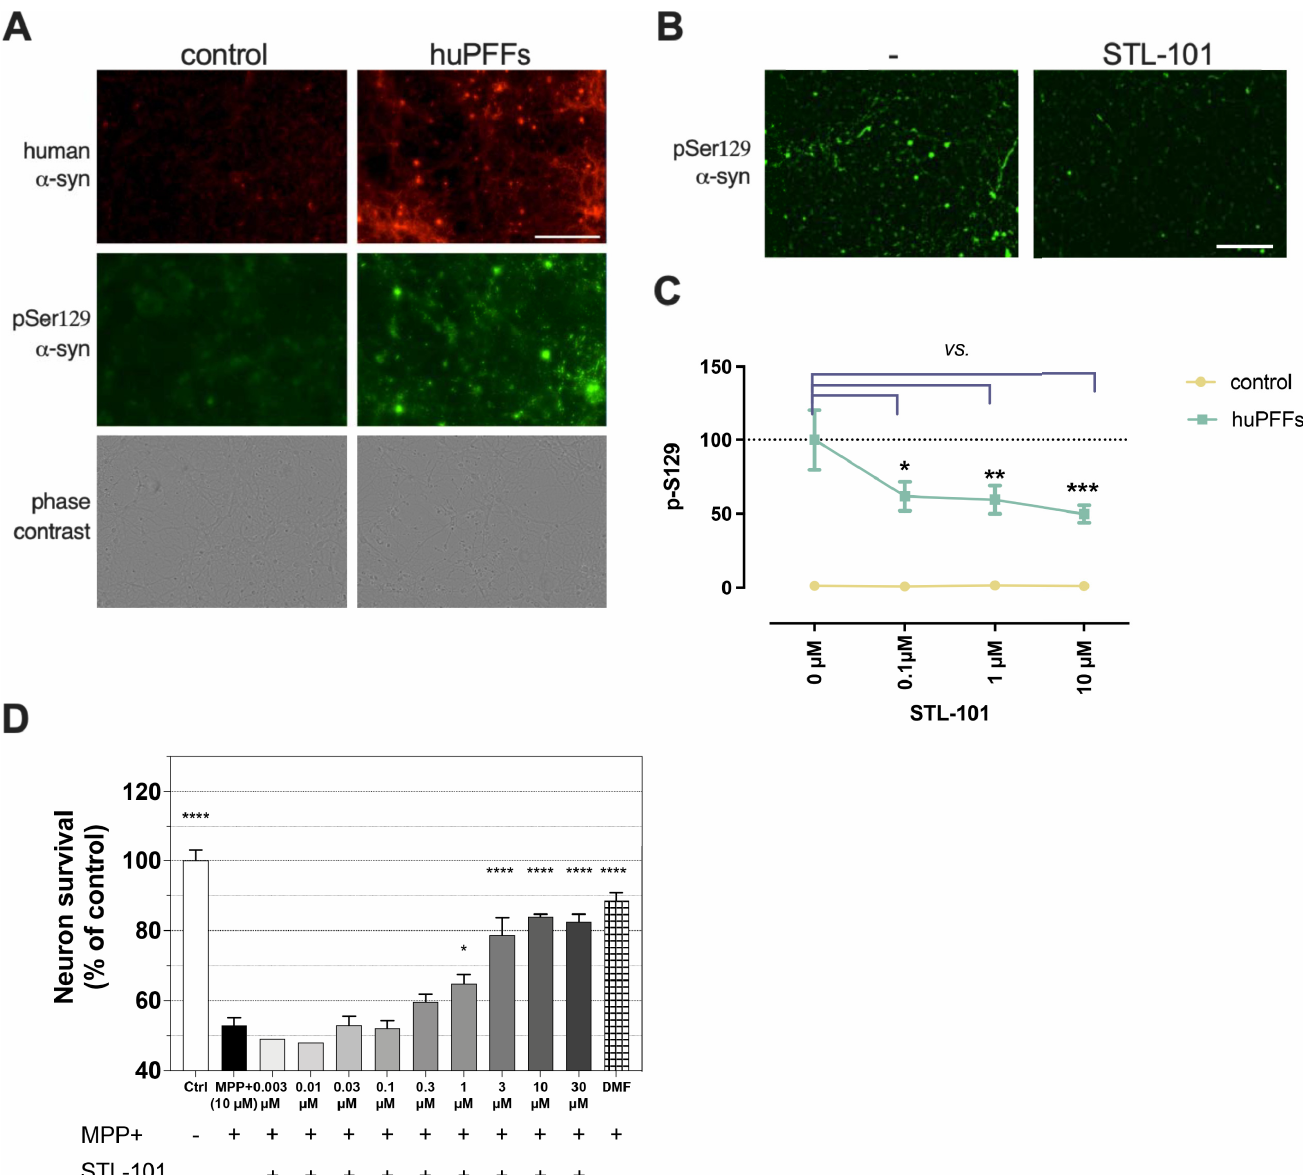
Fig 2. STL-101 decreases α -syn pSer129 in an in vitro model of synucleinopathy and protects dopaminergic (DA) neurons from MPP+ injury. (A) IF of human α -syn (labelled in red with syn211 antibody) and the phosphorylated/aggregated form of α -syn ( α -syn pSer129, labelled in green with EP1536Y antibody) on control and huPFFs-treated mouse cortical neurons. Scale bar = 200 μ m. (B) IF of α -syn pSer129 (EP1536Y antibody) three weeks after huPFFs exposure in untreated (-) and treated mouse cortical neurons with STL-101 at 0.1 μ M. Scale bar = 200 μ m. (C) Quantification of α -syn pSer129 as shown in B. in control (no huPFFs) and huPFFs- exposed mouse cortical neurons treated with STL-101 diluted in PBS at 0, 0.1, 1 and 10 μ M. Data is expressed as mean +/- SEM and analyzed using two-way ANOVA followed by Dunnett’s multiple comparison; ��� p < 0.001 cf. huPFFs + [STL-101] = 0 μ M. (D) STL-101 diluted in culture medium was added at the indicated concentrations to rat DA neuron cultures 1 day before MPP+ intoxication at 10 μ M. 48h after MPP+ injury DA neuron survival was assessed by TH+ neurons counting. Statistical significance was calculated using one-way ANOVA, Dunnett’s multiple comparison test ( � p < 0.05, ���� p < 0.0001 in comparison to MPP + treatment only). n = 3 biological replicates. Dimethyl fumarate (DMF) was used at 10 μ M as a positive control. pretreatment of huPFFs- exposed neurons led to significantly decreased α -syn pSer129, indi- cating a strong decrease in α -syn aggregation (Fig 2B). Quantification of EP1536Y antibody signal showed a ~40% decrease of α -syn pSer129 in cells pretreated with STL-101 at 100 nM